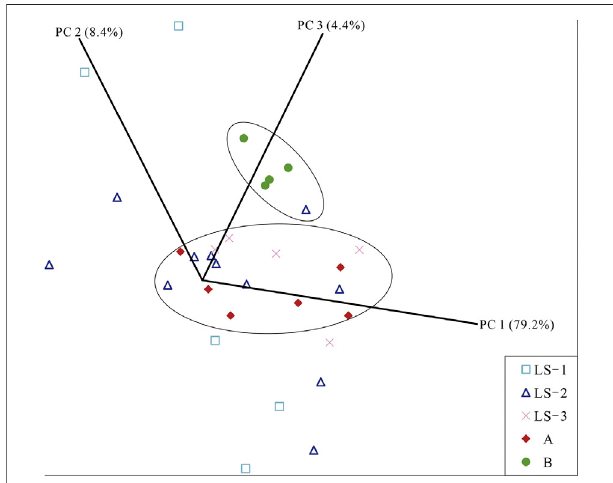
FIGURE 7 | Chemometric results of oil-source rock correlation from the Wushi Sag of the Beibuwan Basin based on principal component analysis. The fi rstthreecomponentsofPCA,includingPC1,PC2,andPC3,accountfor 92% of the total variance in the original dataset.